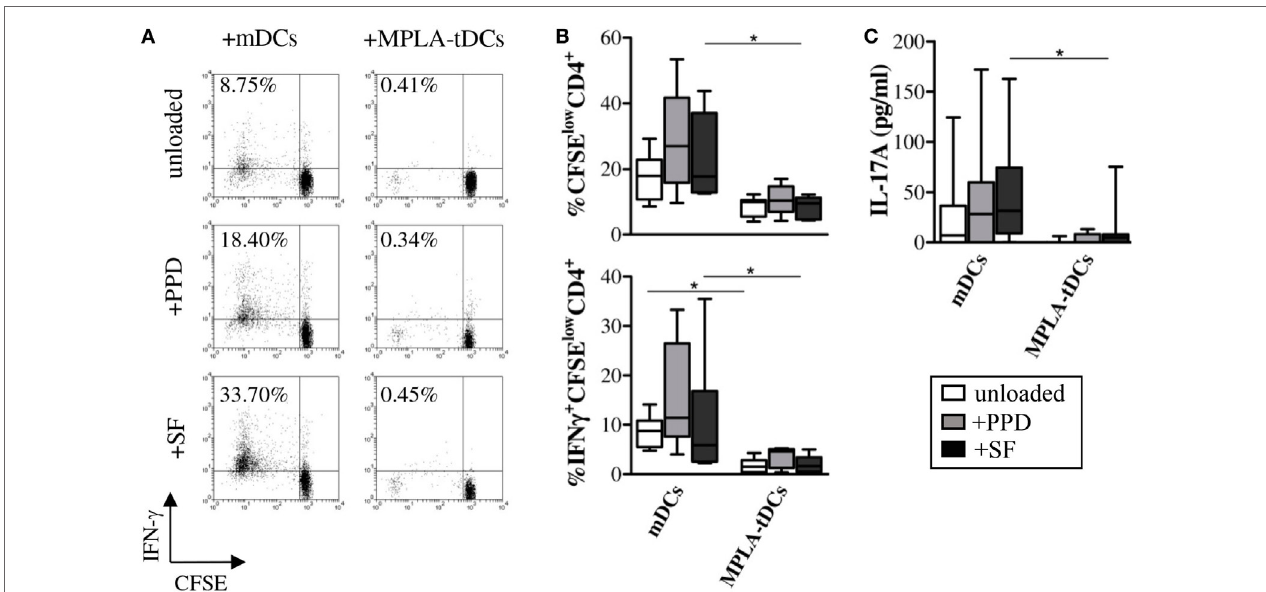
FigUre 4 | MPla-tDcs modulate cD4 + T cell responses to synovial antigens . Monocytes ( n = 6–9) were differentiated into mDCs and MPLA-tDCs as described in the Section “Materials and Methods.” At day 4 of DC generation, 4 h prior to stimulation with MPLA, mDCs and MPLA-tDCs were loaded with 1 μ g/ml tuberculin purified protein derivative (PPD), 200 μ g/ml synovial fluid (SF), or left unloaded for further 24 h. For the assessment of their T cell-stimulatory capacity, antigen-loaded or unloaded mDCs and MPLA-tDCs were co-cultured with autologous CFSE-labeled CD4 + T cells in a ratio of 1:2 (DC:T cell) for 6 days. To detect IFN- γ intracellularly, cells were stimulated with 50 ng/ml phorbol-12-myriastate-13-acetate and 1 μ g/ml ionomycin in the presence of 1 μ g/ml brefeldin-A. Proliferation-associated CFSE dilution and IFN- γ production of CD4 + T cells were analyzed by flow cytometry. (a) Representative dot plots and (B) graphic representation of the percentage of IFN- γ -producing proliferating (CFSE low ) CD4 + T cells are shown. (c) IL-17A secretion was measured in supernatants of co-cultures by ELISA. (B,c) , Box plots show median, 25- and 75%-quartiles and both extreme values (* P <